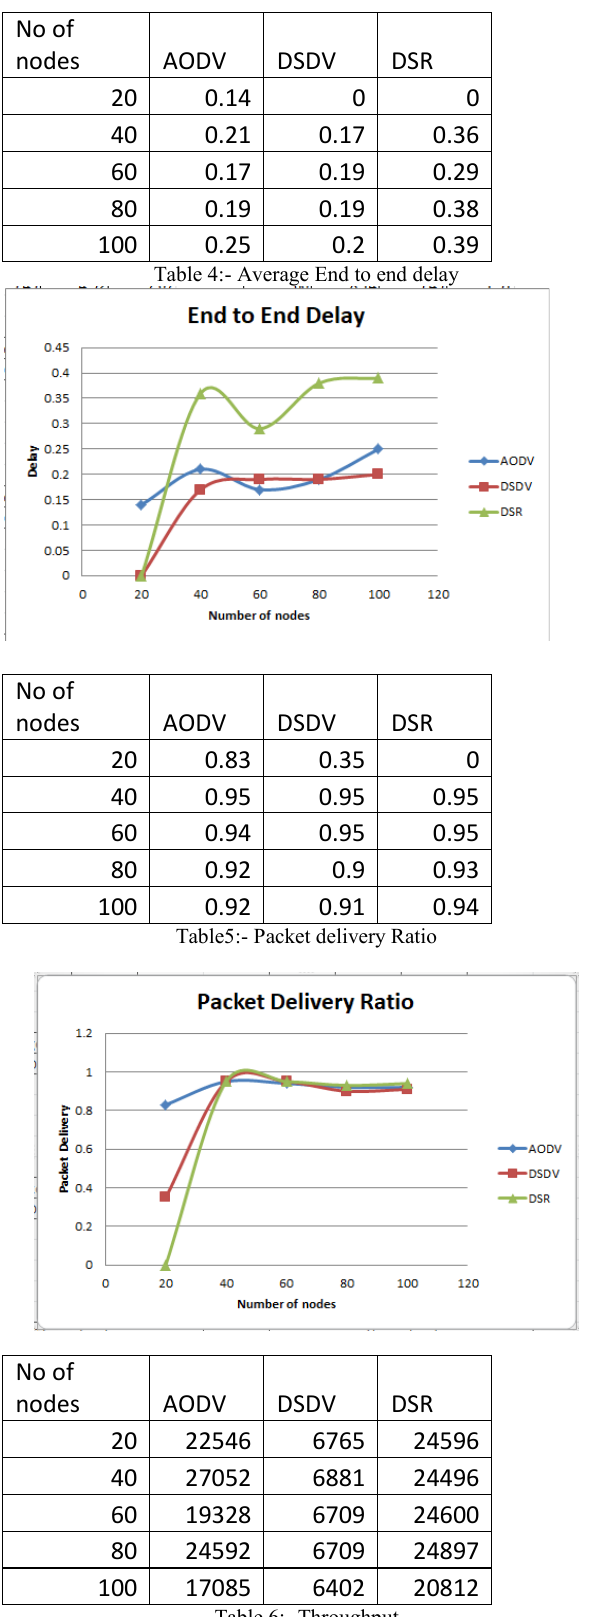
Table 6:- Throughput